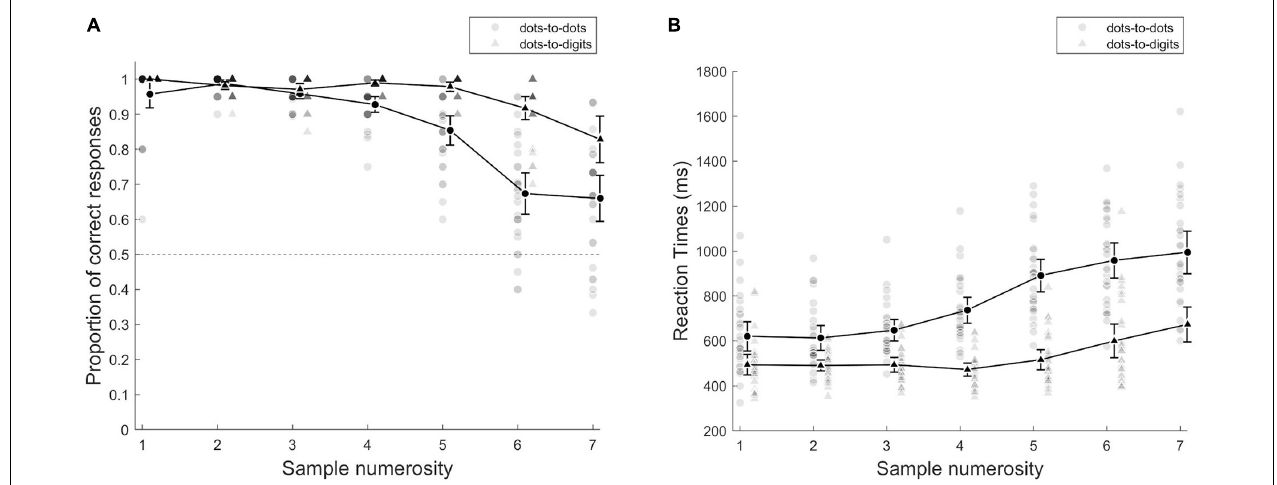
FIGURE 2 | (A) Proportion of correct responses and (B) mean reaction times as a function of sample numerosity. Individual points represent single participants, and group averages are presented with black lines, separately for each condition. Error bars indicate 95% CI.